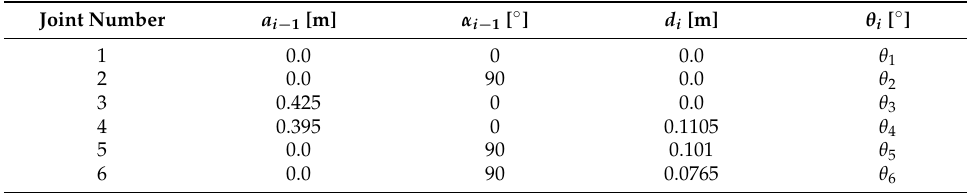
Table 2. Denavit–Hartenberg parameters for ES5